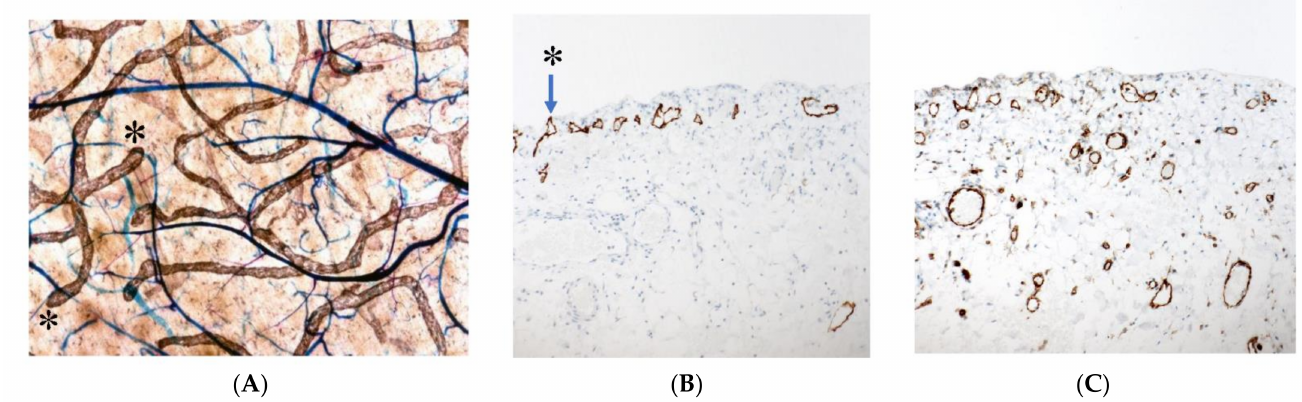
Figure 2. ( A ) Whole-mount specimens of Morrison’s pouch stained by alkaline-phosphatase (ALP) and 5 (cid:48) -nucleotidase double enzyme staining method show subperitoneal blood capillaries (blue) and lymphatic vessels (brown). ( B ) Lymphatic vessels and initial lymphatic vessels (*) stained with D2-40 monoclonal antibody. ( C ) Blood vessels stained with anti-CD31 monoclonal antibody. The specimens were obtained from macroscopically normal Morrison’s pouch from patients with gastric cancer. ( A ) ALP-5 (cid:48) -Nase double staining. * shows initial lymphatic vessel. ( B ) D2-40 staining shows submesothelial lymphatic vessels and initial lymphatic vessels. ( C ) CD31 staining shows submesothelial blood